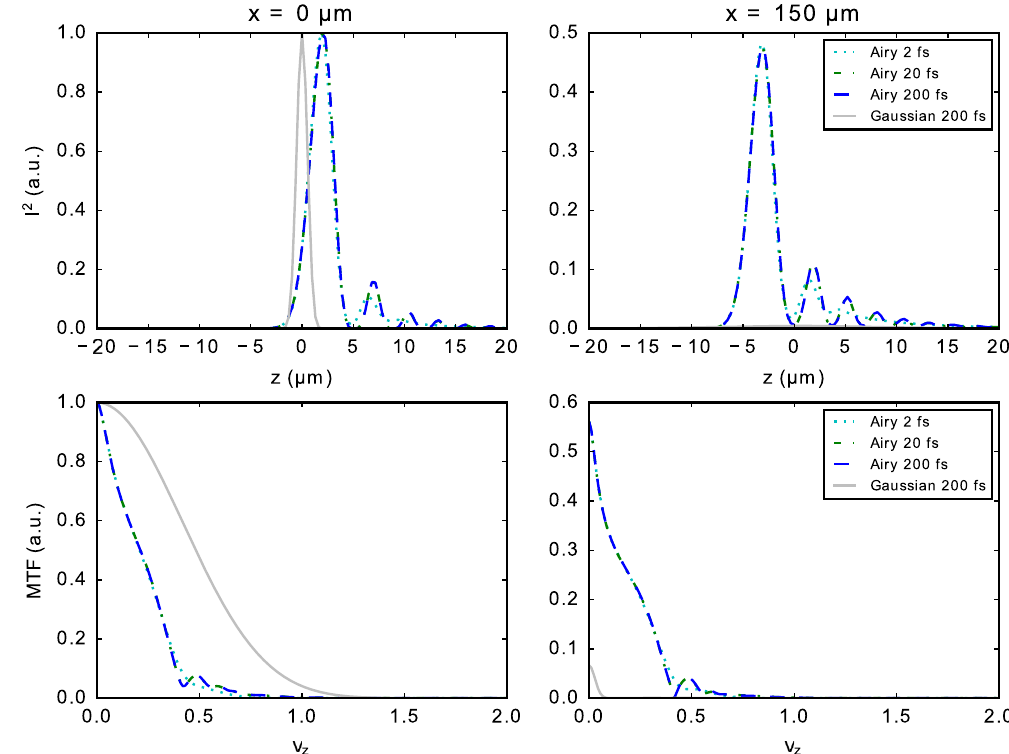
Figure 2. Simulated excitation intensity squared point spread functions (I 2 ) and corresponding modulation transfer functions (MTF) for the two-photon Gaussian and Airy light sheets ( α = 7) with different pulse durations and a Gaussian spectrum. The plots are shown at the waist x = 0 μ m and at distance x = 150 μ m from the waist. The spatial frequency ν z is normalized to maximum transmitted spatial frequency 2 NA / λ , numerical aperture NA = 0.3 and excitation wavelength λ = 800